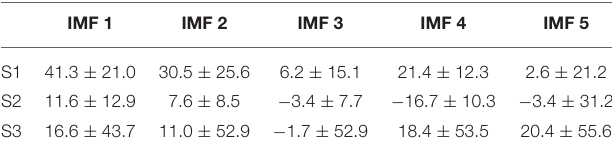
TABLE 2 | Descriptive statistics of the variation of power for Cz electrode for the first 5 IMFs during the ten single trials.